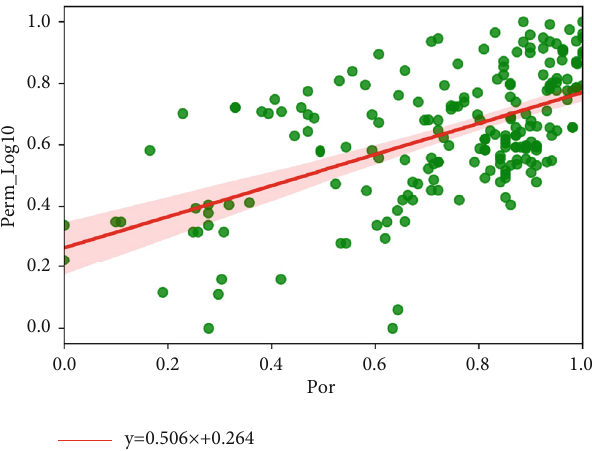
Figure 11: Cross-plot of the normalized core porosity and core permeability.